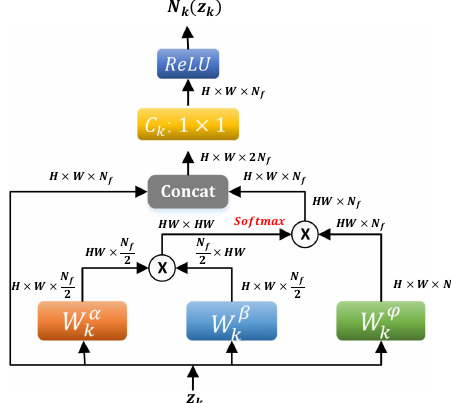
Figure 2. Data flow in the nonlocal operator N k (16). “ (cid:78) ” denotes matrix multiplication. Both input z k and output N ( z k ) are of the same shape H × W × N f (height × width × #channel) of the